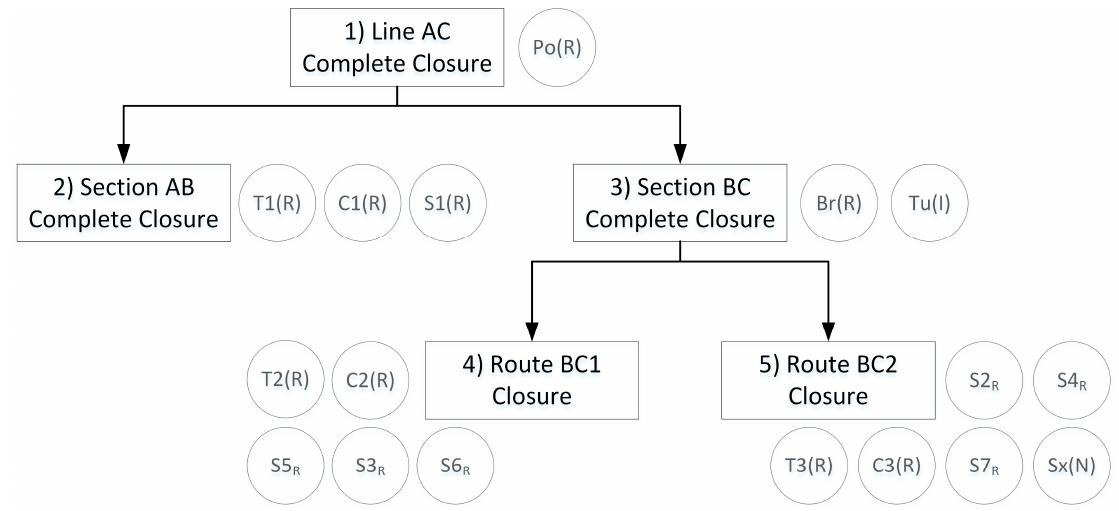
Figure 5. Hierarchical network state structure with assigned interventions.